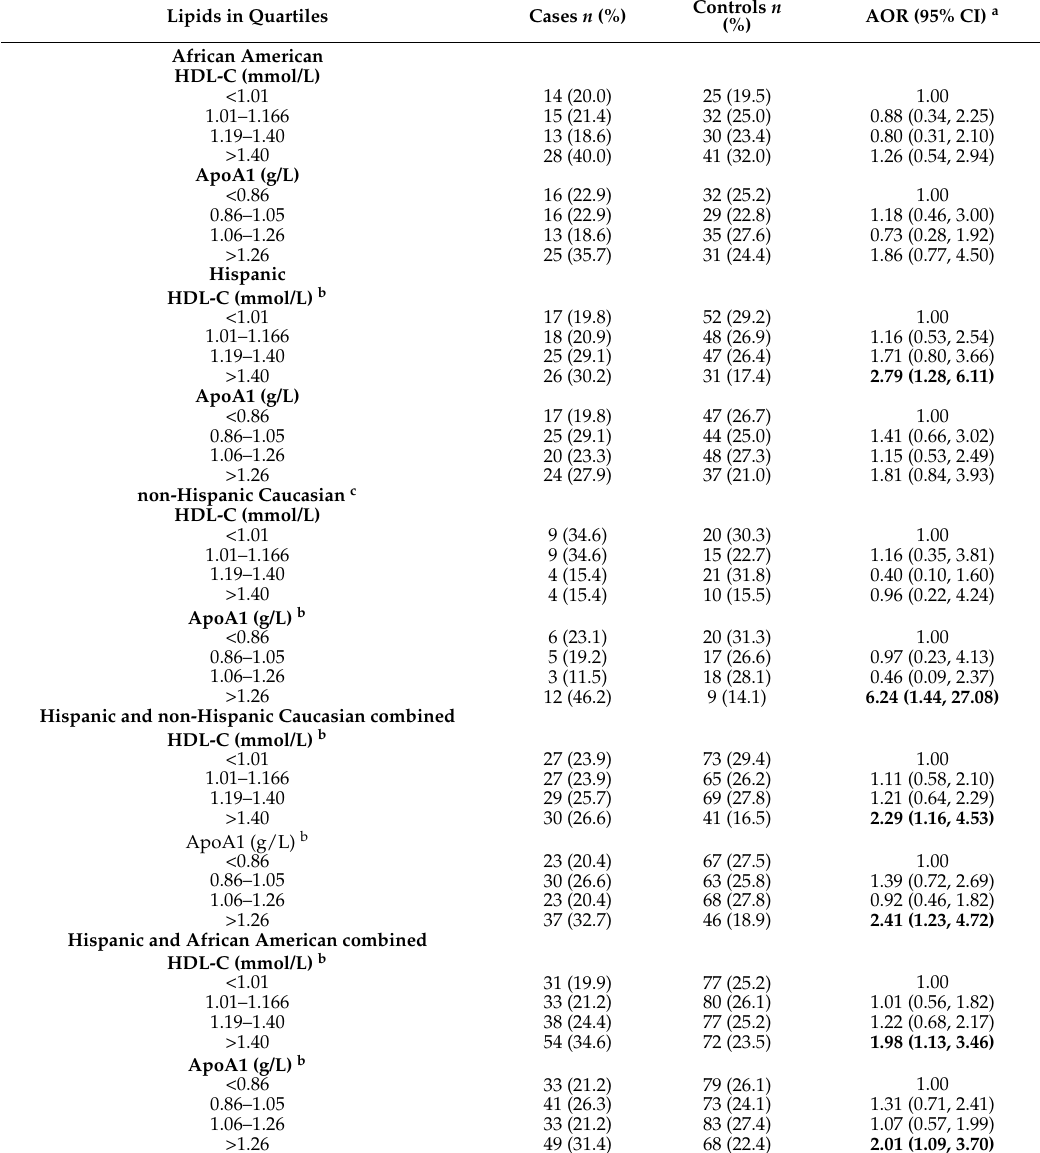
Table 6. Association of elevated maternal HDL-C and apoA1 with spontaneous preterm delivery by racial/ethnic group: comparing the lowest quartile to other